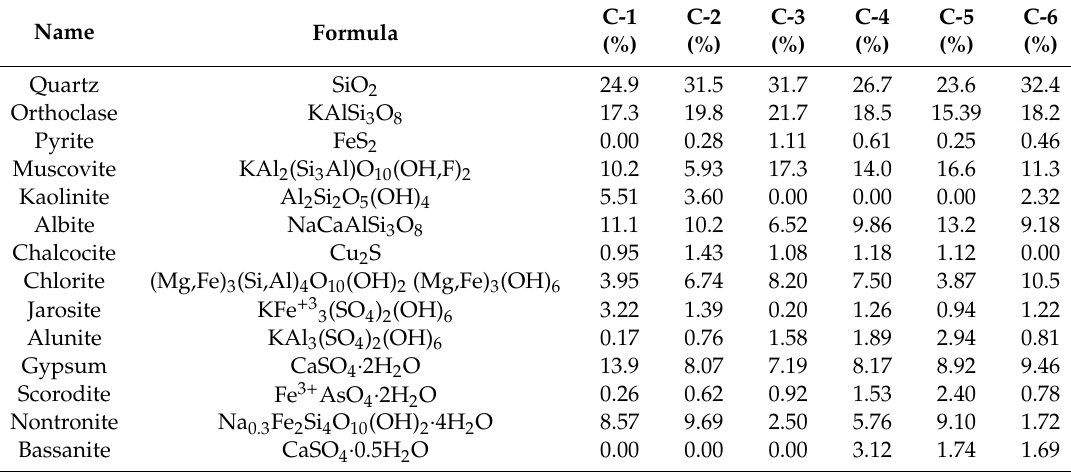
Table 8. X-ray analysis of the leaching